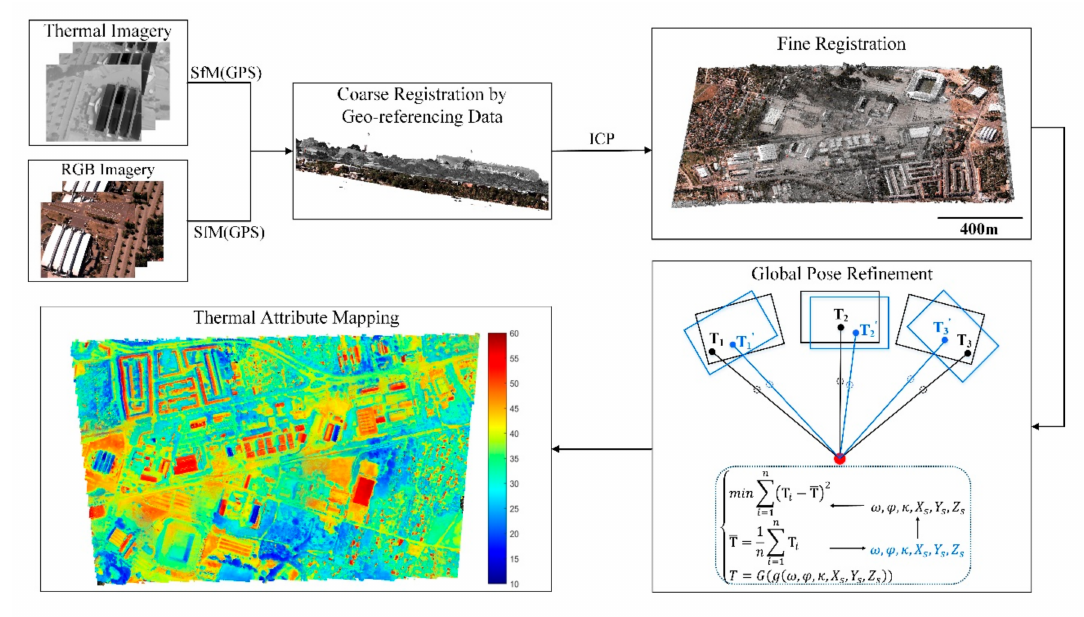
Figure 3. Registration